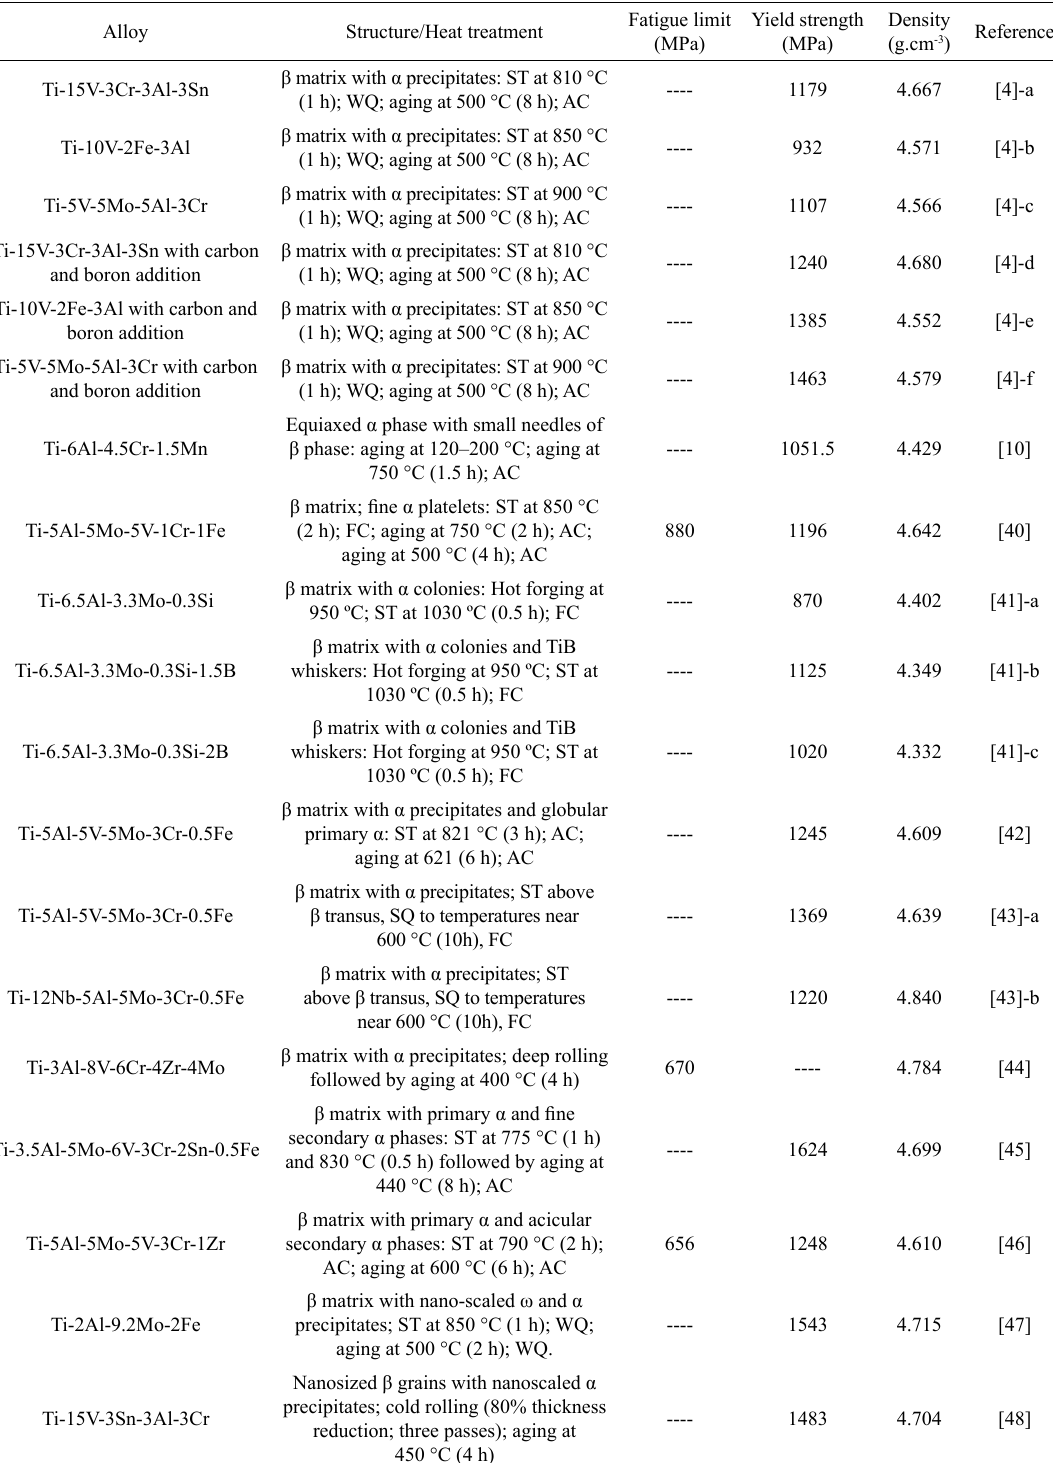
Table 1. Microstructure and engineering properties of aircraft titanium alloys. Heat treatment details abbreviated*. Alloy Structure/Heat treatment